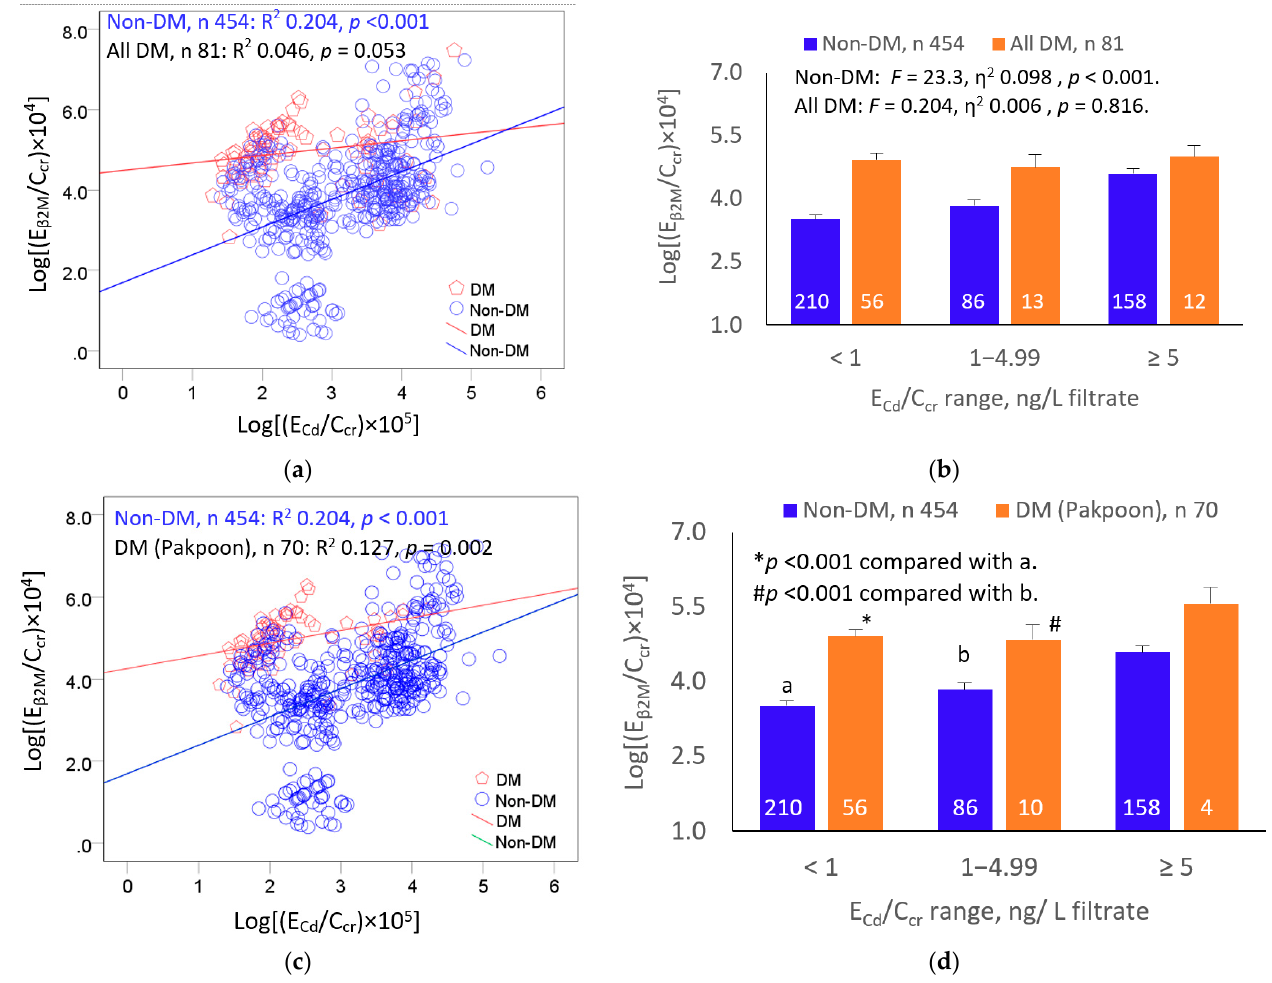
Figure 1. Effects of diabetes and cadmium exposure on β 2 M excretion. Scatterplot ( a ) relates log[(E β 2M /C cr ) × 10 4 ] to log[(E Cd /C cr ) × 10 5 ] in all diabetic and all non-diabetic participants. Bar graph ( b ) depicts mean log[(E β 2M /C cr ) × 10 4 ] in all diabetic and non-diabetics grouped by ranges of log[(E Cd /C cr ) × 10 5 ]. Sca tt erplot ( c ) relates log[(E β 2M /C cr ) × 10 4 ] to log[(E Cd /C cr ) × 10 5 ] in diabetics from Pakpoon and all non-diabetics. Bar graph ( d ) depicts mean log[(E β 2M /C cr ) × 10 4 ] in diabetics from Pakpoon and all non-diabetics grouped by ranges of log[(E Cd /C cr ) × 10 5 ]. Coe ffi cients of determina- tion (R 2 ) and p -values are provided for all sca tt erplots. Mean values were adjusted for age, BMI, and interactions. Units of E β 2M /C cr and E Cd /C cr are ng/L of fi ltrate. A direct relationship was seen between E β 2M /C cr and E Cd /C cr in the non-diabetic group (R 2 0.136, p < 0.001) (Figure 1a). After controlling for interactions and di ff erences in age